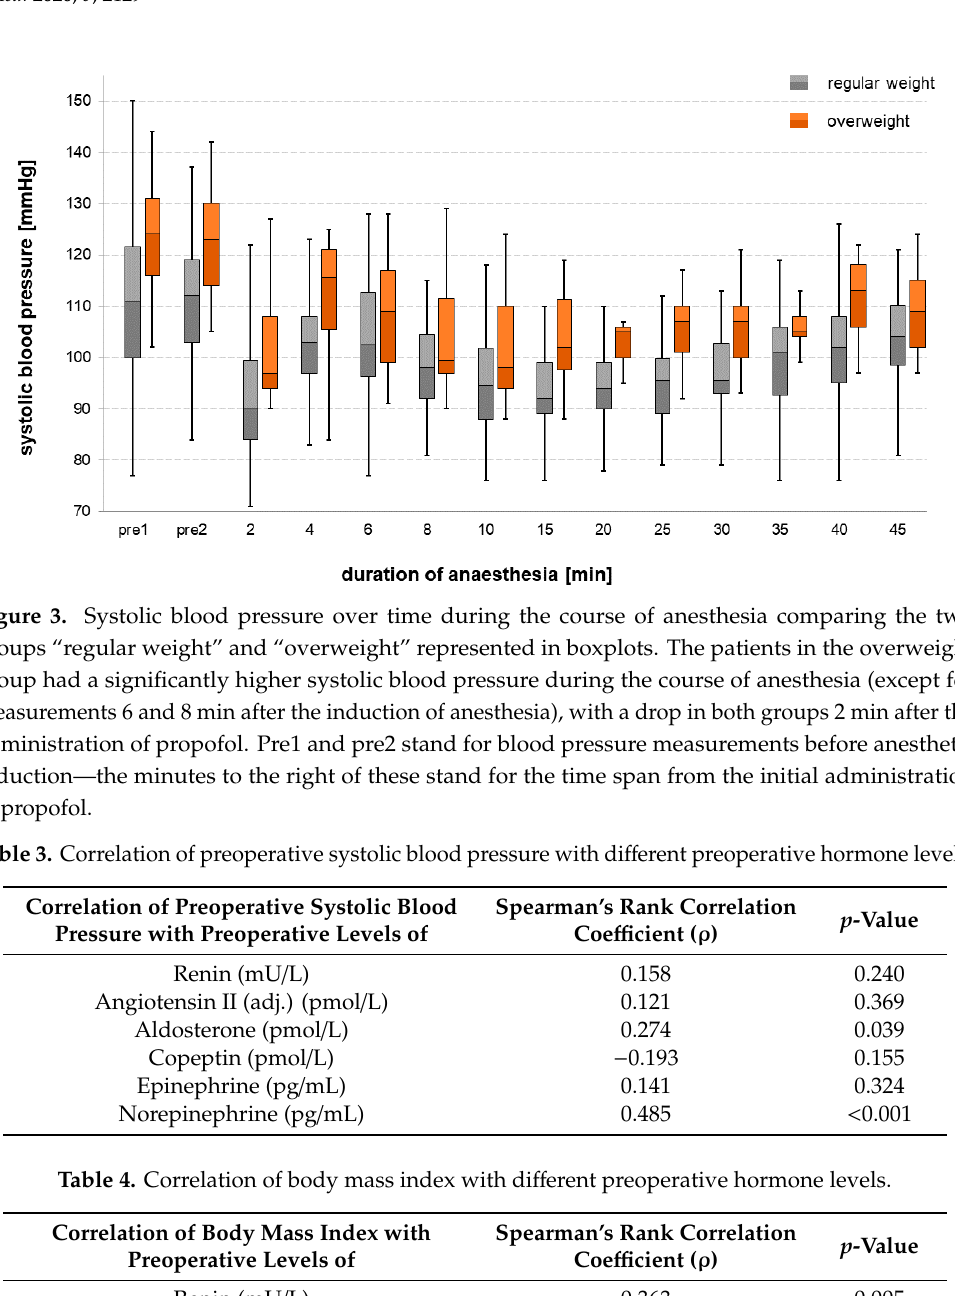
Figure 2. Correlation between body mass index and preoperative systolic blood pressure for all patients ( n = 59; Spearman’s correlation: ρ = 0.452, p < 0.001). The squares stand for individual patients, the dotted line symbolizes the correlation.